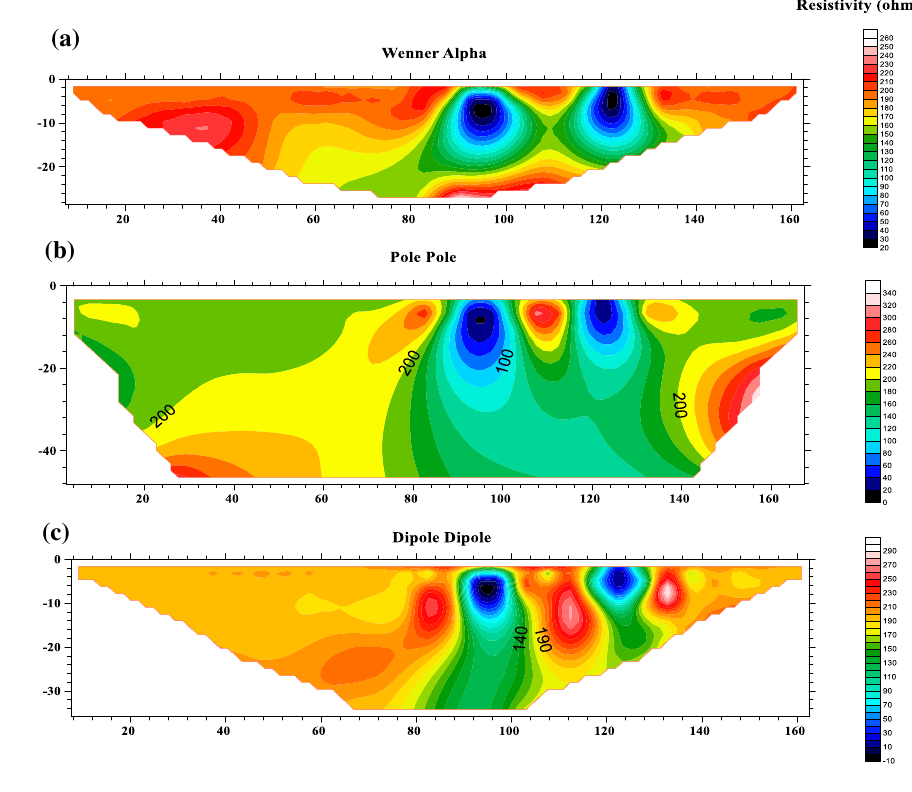
Fig. 4 Synthetic response of the synthetic model using conventional electric arrays,